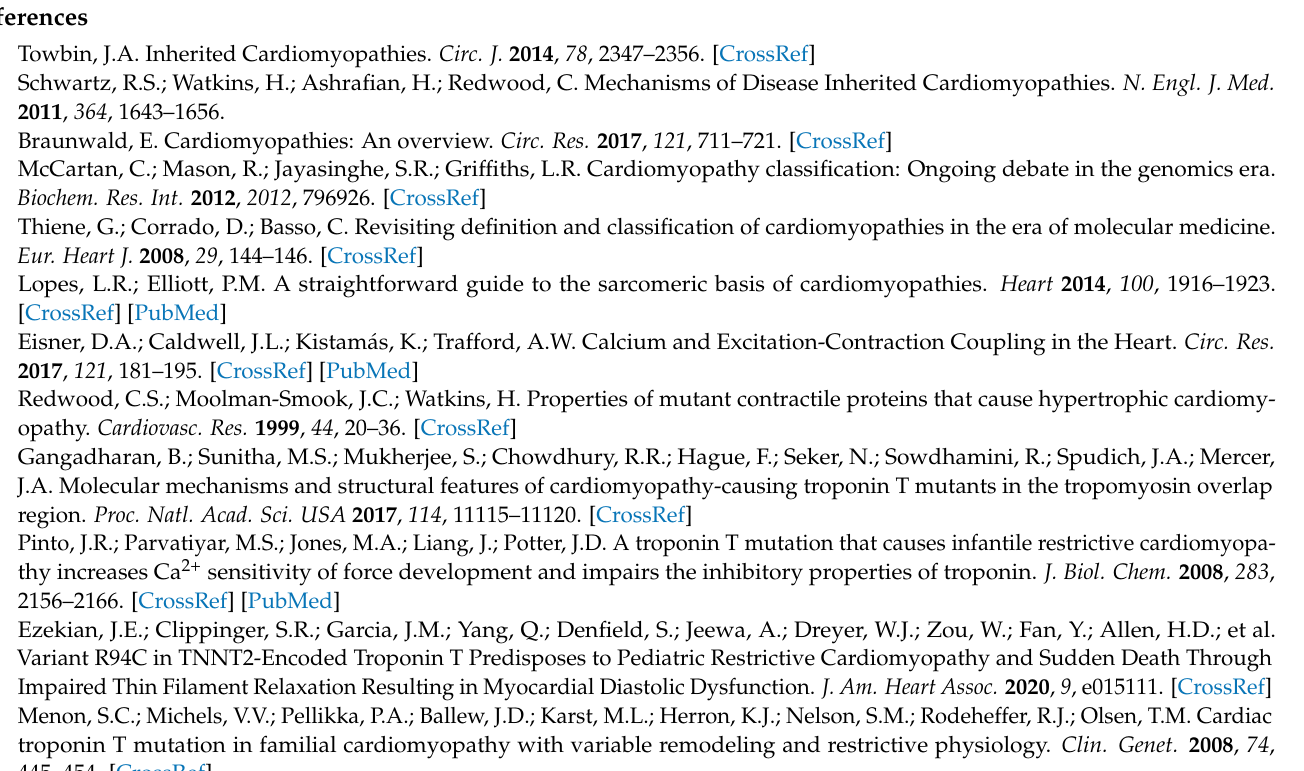
Figure S2: Heart rate from a brightfield high-speed video imaging of tnnt2a+/hu11260 at 5 dpf, Figure S3: Representative embryonic pictures of the different genotypes at 3 dpf and 5 dpf